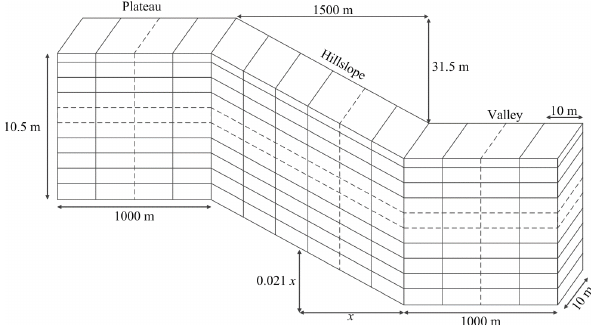
Figure 5. The simulated landform and the definition of nodes.